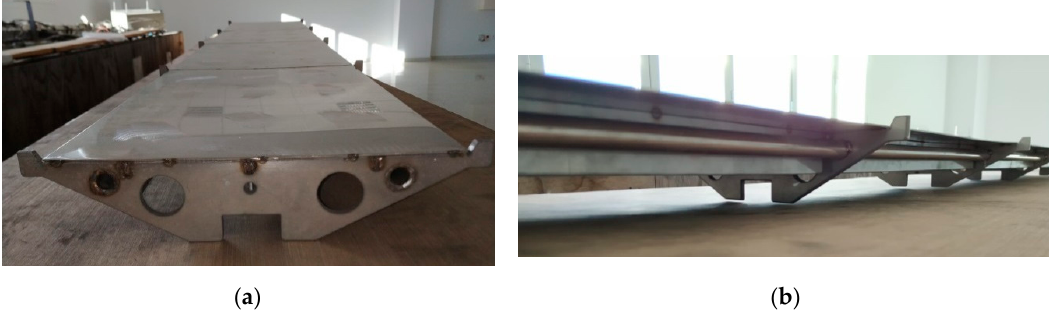
Figure 6. Assembly of a curved rectangular plate attached to a set of preformed ribs: (a) front view of the assembly and (b) lateral (longitudinal) view of the assembly.